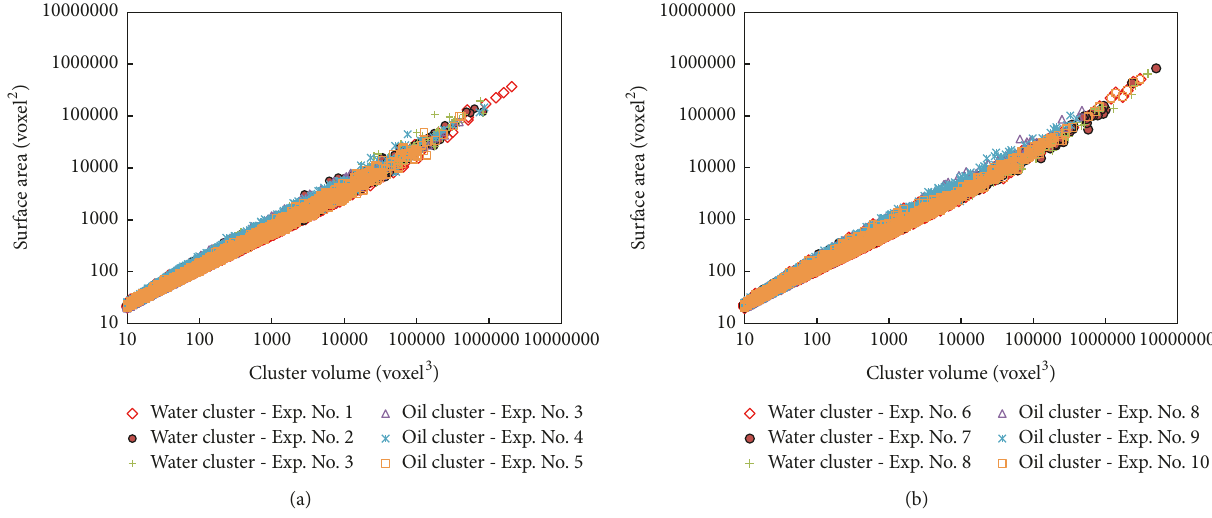
Figure 13: Water and oil cluster surface areas in the entire displacement processes plotted against cluster volumes: (a) water-wet plug; (b) oil-wet